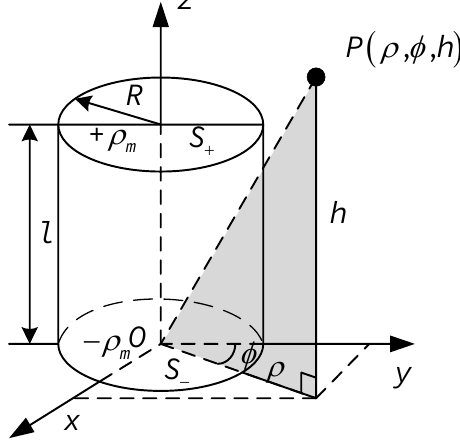
Figure 4. Schematic diagram of cylindrical permanent magnet.